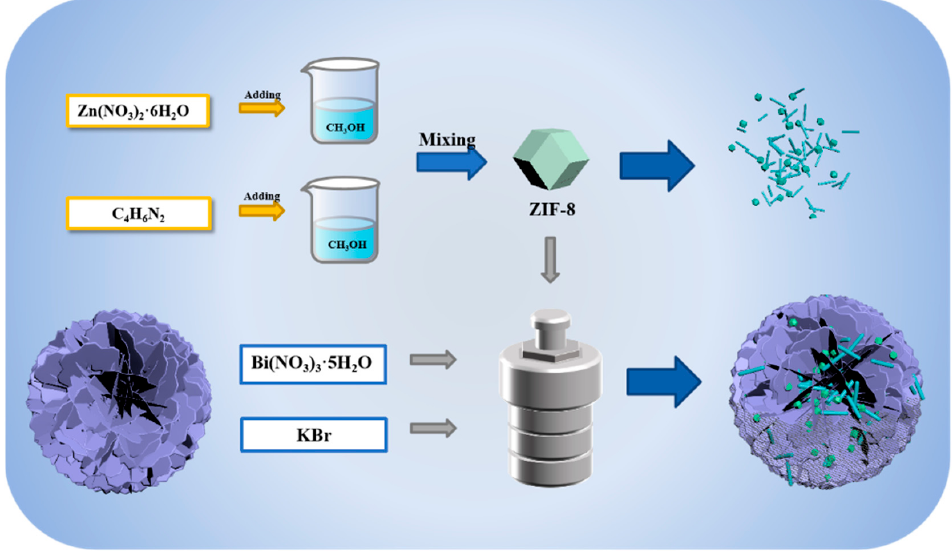
Scheme 2. Preparation diagram of BiOBr/ZIF − 8/ZnO.